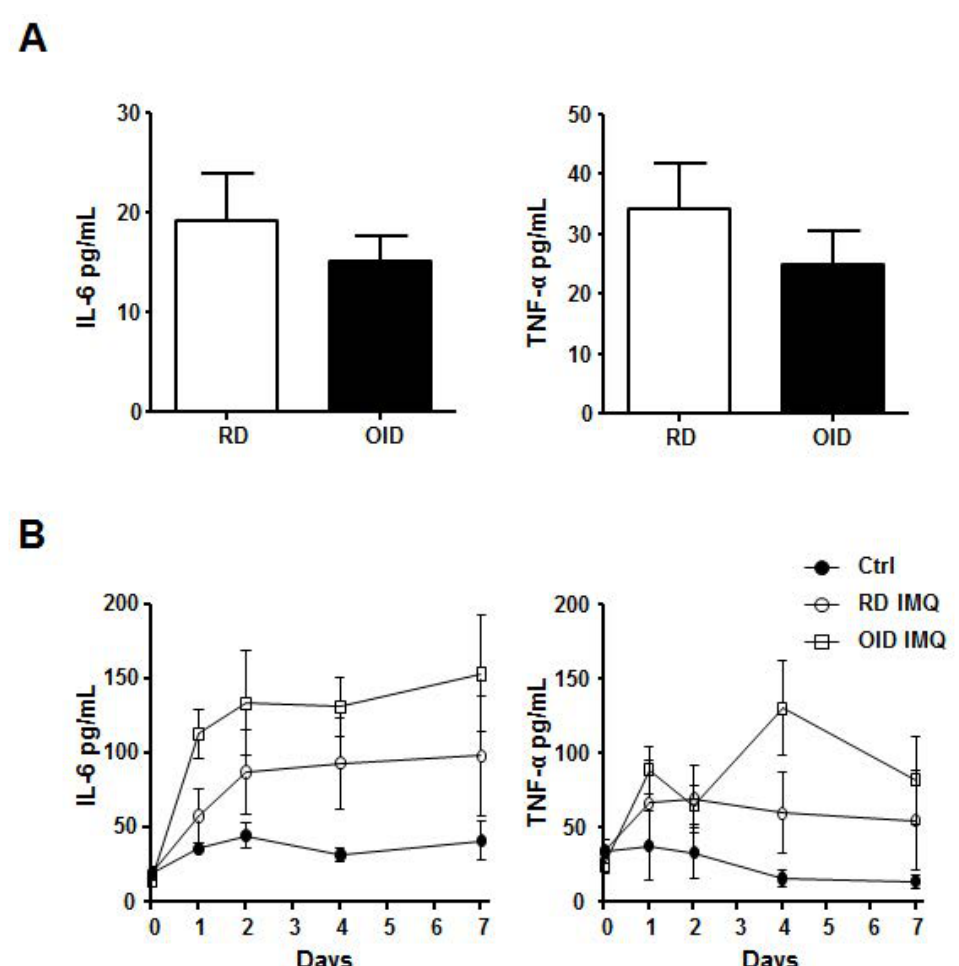
Figure 2. CBA-assayed proinflammatory cytokines IL-6 and TNF- α in imiquimod (IMQ)- treated mice reared on an obesity-inducing diet (OID), as compared to a regular diet (RD) ( n = 4–6/group/each time point). Subfigure ( A ) represents the initial levels of cytokines measured prior to imiquimod treatment, while subfigure ( B ) presents them after 1, 2, 4, and 7 days from imiquimod treatment. Control (Ctrl) indicates the mice not treated with imiquimod. Data indicate the concentrations of cytokines ± SEM in serum and the results are representatives of two independently performed